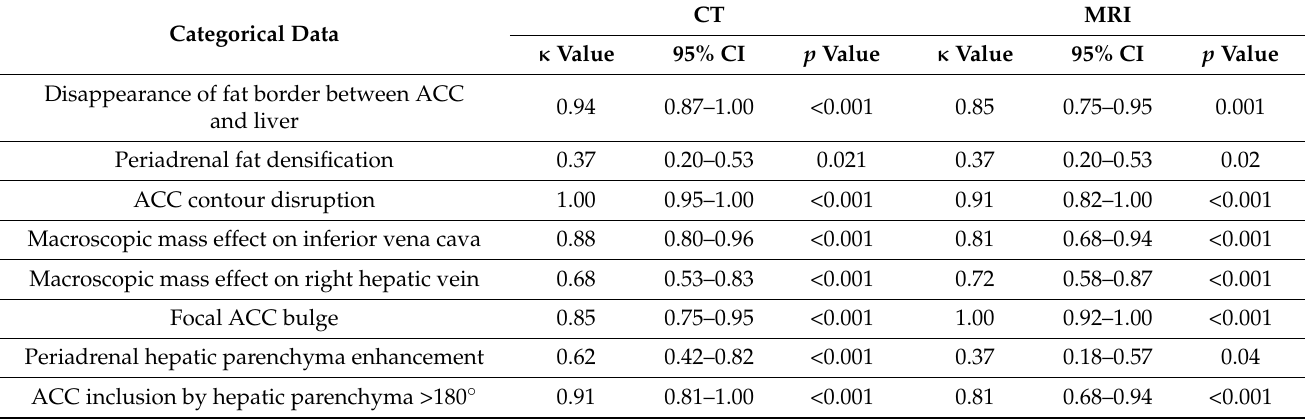
Table 3. Interobserver agreement for categorical data in 29 patients with operated right